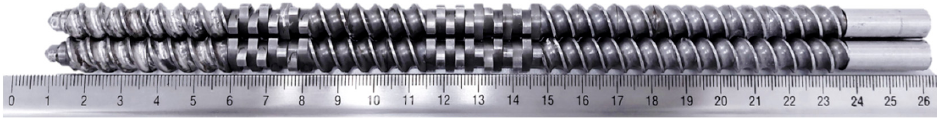
Figure 2. Geometry of the 10-millimeter screw set used in the melt extrusion line. To stretch the extrudate, a 100 × 473 compl. V2 conveyor belt from Three-Tec (Sion, Switzerland), modified to include a stainless-steel pressure roller, was used. All the components required for assembly were self-constructed and created from PLA using 3D printing. The spinning apparatus was also self-constructed, and it was manufactured by means of 3D printing. The spinning wheel was driven by a stepper motor NEMA 24